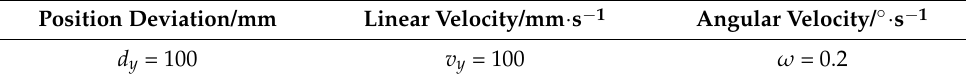
Figure 12. Position versus time of the active part: ( a ) in x direction; ( b ) in z direction. Table 3. The initial docking conditions of the simulation analysis for eight initial pose conditions.